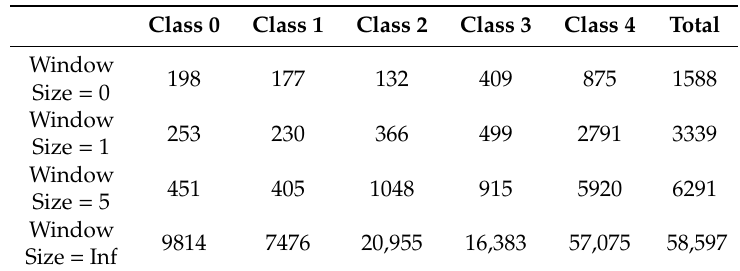
Table 1. Classification of putative orthologous RNA-editing events within coding loci for each range used. An event can belong to more than one class depending on the isoform analyzed.